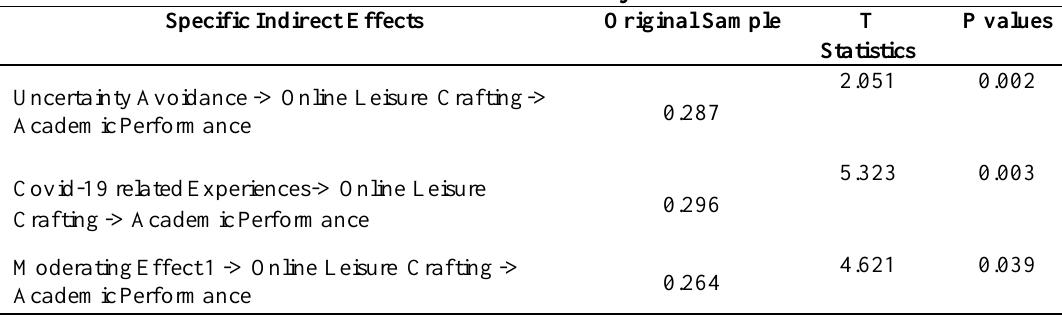
Table.6. Mediation analysis